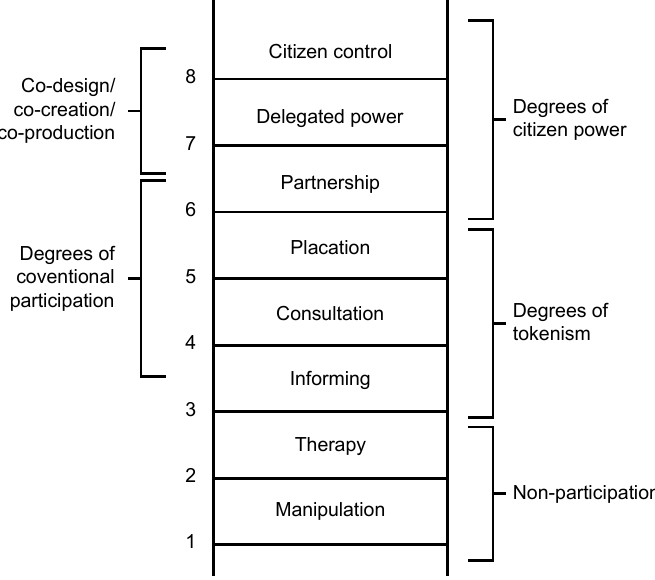
Figure 1. Author’s modified version of Arnstein’s (1969) Ladder of Participation (Adapted from [22]).